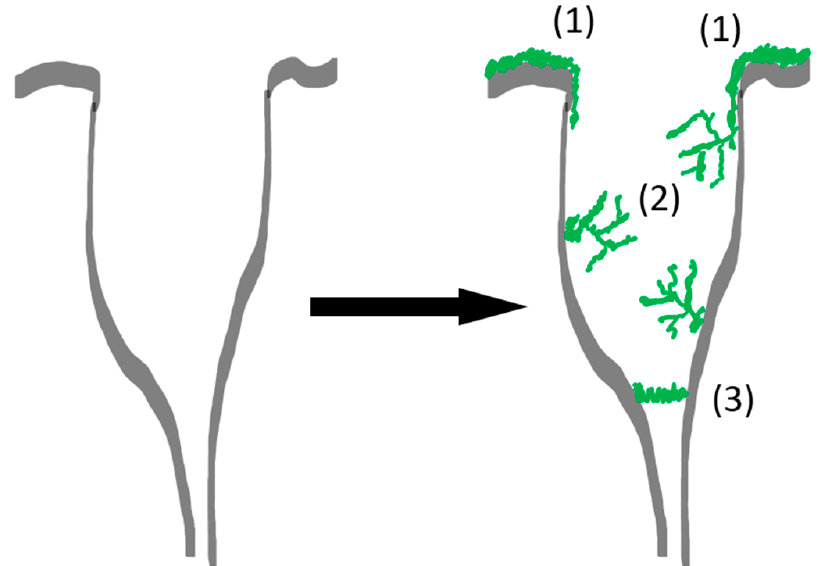
Figure 9. Schematic representation of two coupled pores. The large pore (macropore) is exposed to the gas phase with activated monomer (not shown). A layer at the outer surface (1), porous structures from the deposited polymer (2) and a thin layer at the coupling point of two pores (3) are shown. The layer (1) does not lead to an increase in the specific surface area, while the structures (2) and (3) do. Deposition of the layer (3) may be due to a limited mass transfer through the smaller pore.